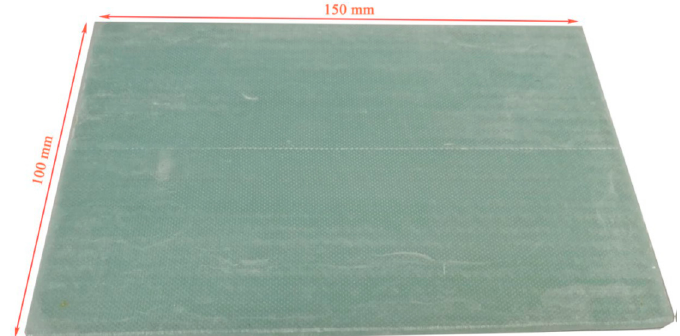
Figure 1. The GFRC material laminate.